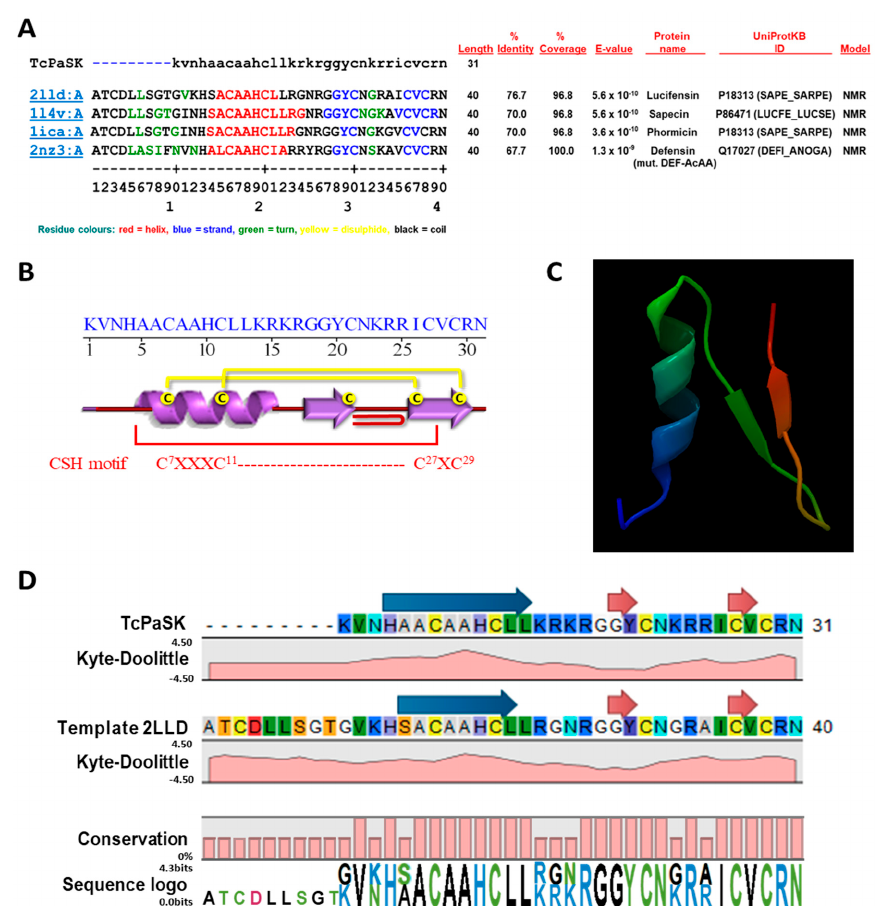
Figure 1. Structural organization, properties and 3D modelling of TcPaSK peptide. ( A ) Multiple sequence alignment of the TcPaSK peptide sequence using Sequence Annotated by Structure (SAS) tool (https://www.ebi.ac.uk/thornton-srv/databases/sas/ [25]) that performs a FASTA search against the PDB database (http://www.rcsb.org/). Alignment was used for template identification. On the basis of the template properties obtained from CLC genomics workbench v 20 analysis, 2LLD sequence was selected as reference for the 3D-modelling of TcPaSK structure. ( B ) Schematic representation of the secondary structure of the TcPaSK peptide. The α -helix is represented by a purple spiral ribbon and the β -strands by purple arrows. The different structural motifs, including a β -hairpin (represented by ⊃ ) and a CHS motif, are indicated. Disulphide bridges are represented as yellow connecting lines. ( C ) Modelling of the 3D-structure of TcPaSK peptide using SWISS-MODEL software (http://swissmodel.expasy.org) using 2LLD as selected template. ( D ) Comparison of Kyte–Doolittle regional hydropathy prediction of TcPaSK and 2LLD template, and generation of the sequence logo based on the conservation of the target-template alignment, using the CLC genomics workbench v 20. Blue arrows indicate a predicted α -helix region and red arrows correspond to predicted β -strands.